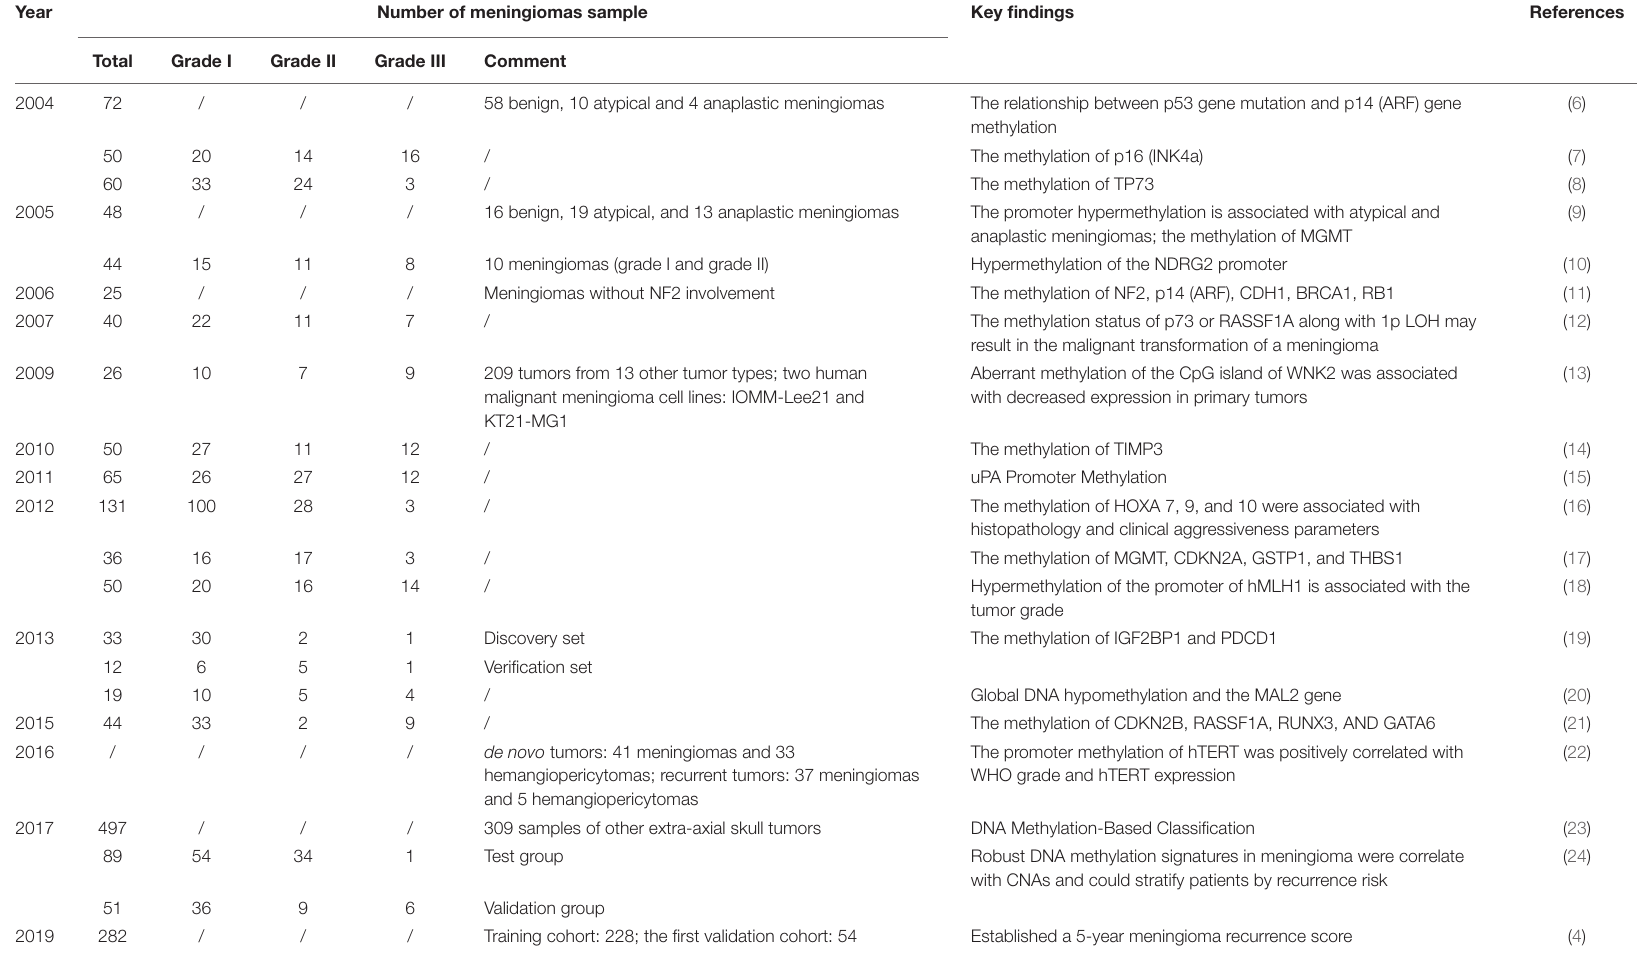
TABLE 1 | Key findings on meningiomas in the last two decades. Year Number of meningiomas sample Key